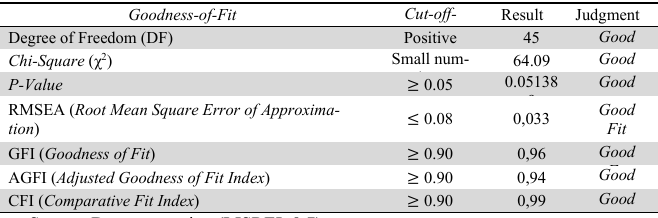
Fig. 2. Standardized loading factor and results of t-test (t-value, inside the bracket)